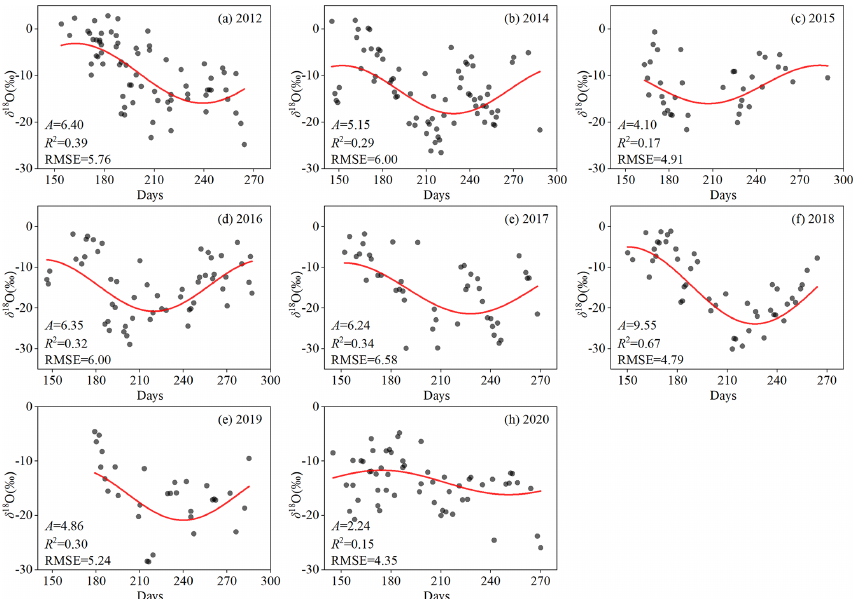
Figure 8. Fitted sine-wave regression models to δ 18 O in precipitation in Xiaoliuyu catchment during 2012 and 2014–2020. A is the amplitude, and RMSE is root mean square error for the modelled isotopic signature.